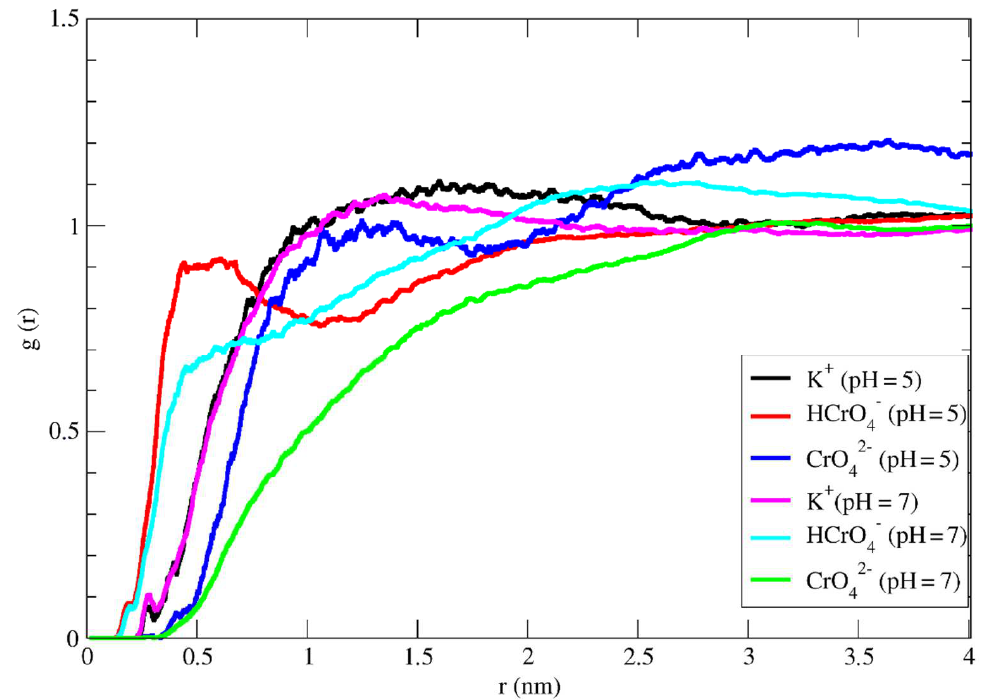
Figure 8. The radial distribution function of K + , HCrO 4 − and CrO 42 − ions around activated carbon surface in the solution of MgCl 2 .